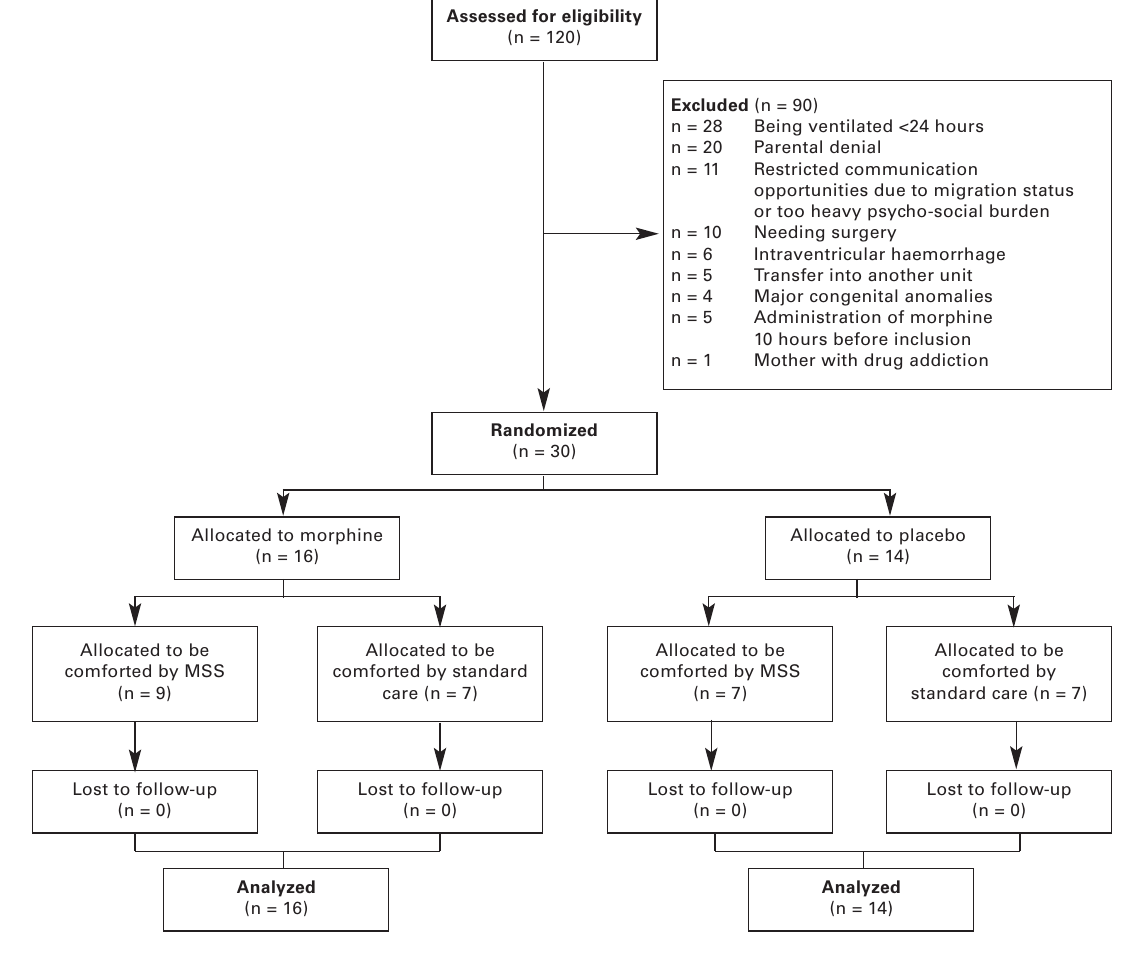
Figure 1 Diagram of randomisation and